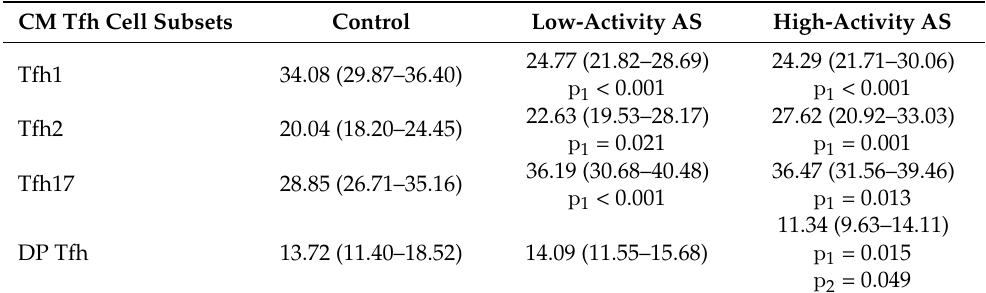
Table 4. Peripheral blood CM Tfh-cell subset composition (%) in activity-driven AS patients ( Ме